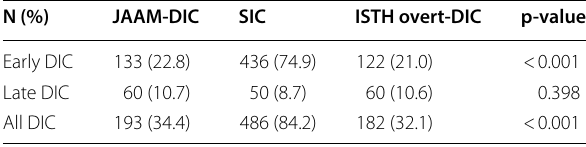
Table 2 Number of patients on day of DIC diagnosis by the three sets of diagnostic